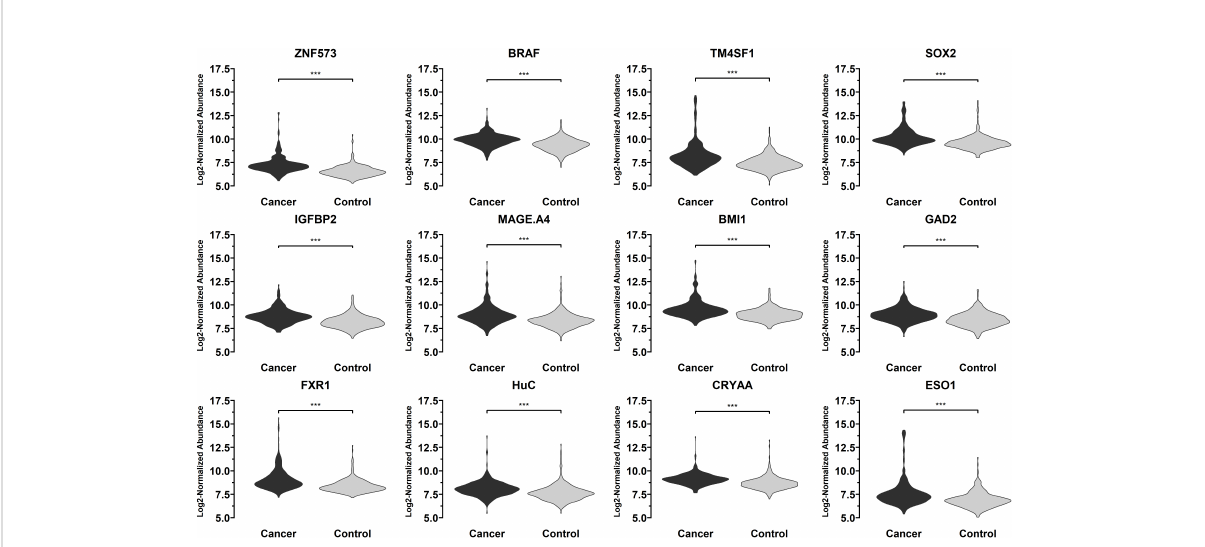
FIGURE 4 Distribution of the levels of autoantibodies targeting 12 lung cancer antigens (ZNF573, BRAF, TM4SF1, SOX2, IGFBP2, MAGE.A4, BMI1, GAD2, FXR1, HuC, CRYAA, ESO1) in 332 sera from patients with early-stage NSCLC and 375 control samples in the training set samples. The meaning of "***" indicates that the two sets of data have a very signi fi cant difference (P < 0.001).